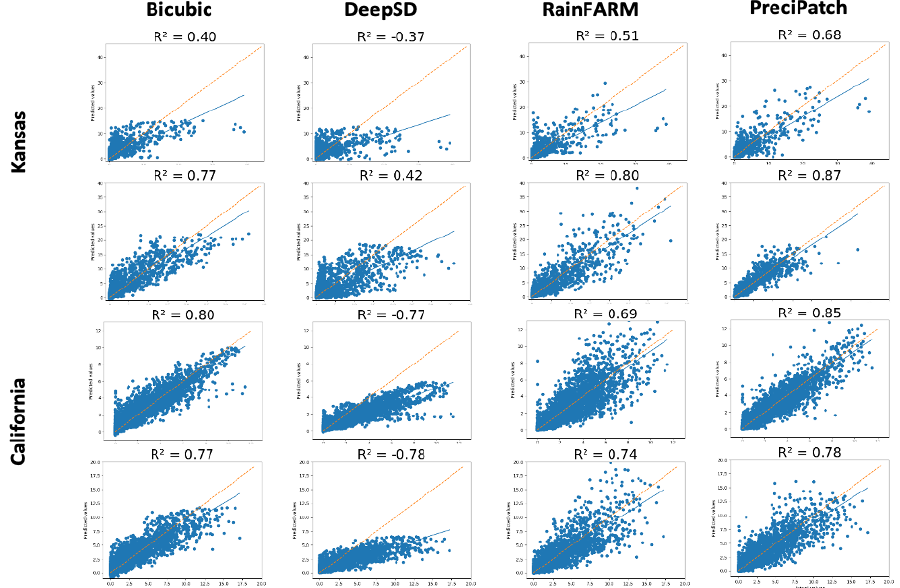
Figure 7. Kansas and California—R². The x-axis refers to the ground truth, and the y-axis is the prediction. The 45 degrees line in each graph is the perfect match reference line between the prediction and the ground truth, showing as the dashed line, the solid line is the trending line. 1st row: hourly precipitation at Kansas area on 2018/7/29 (04:30:00 UTC), 2nd row: hourly precipitation at Kansas area on 2018/7/29 (08:30:00 UTC), 3rd row: hourly precipitation at California area on 2018/1/9 (00:30:00 UTC), 4th row: hourly precipitation at California area on 2018/1/9 (08:30:00 UTC). Table 9. Statistical comparison.